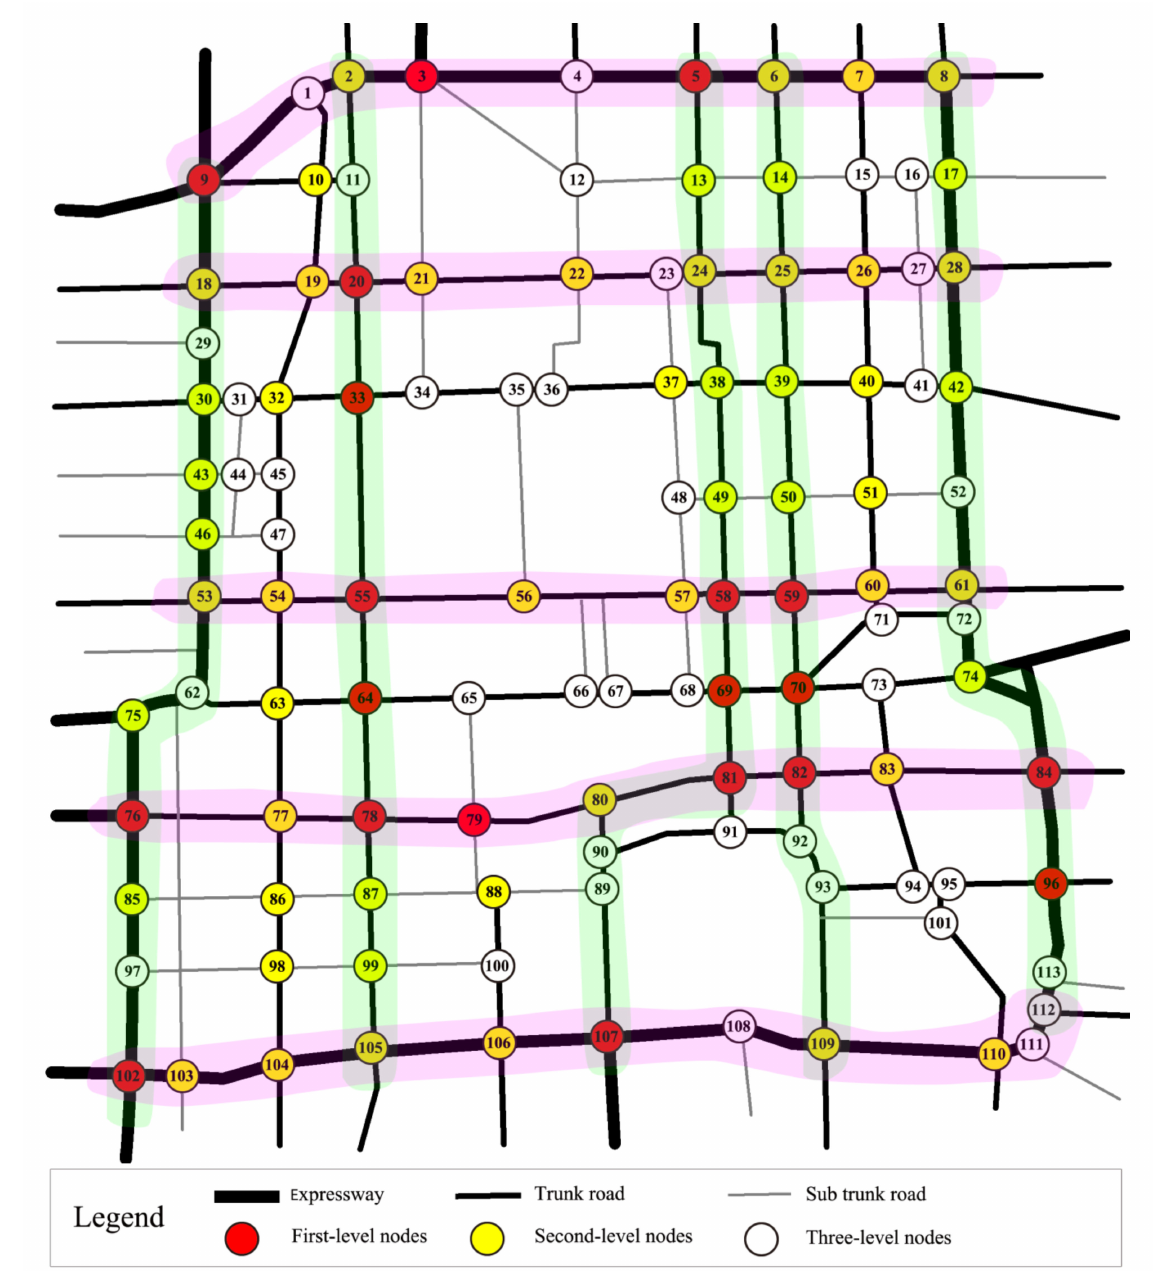
Figure 14. Distribution map of key nodes of the urban road